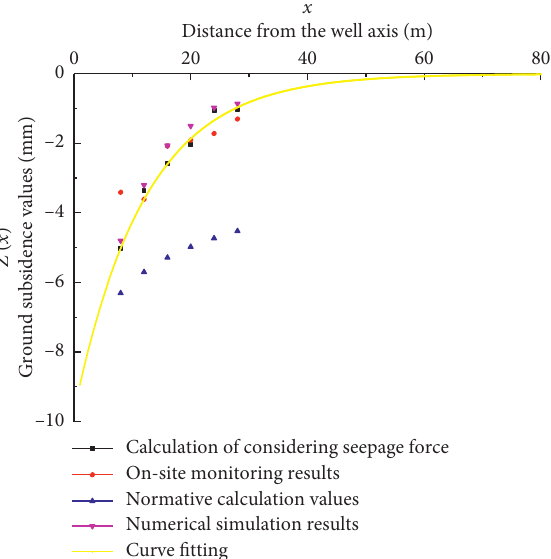
Figure 35: Curve fitting for ground subsidence around the foundation